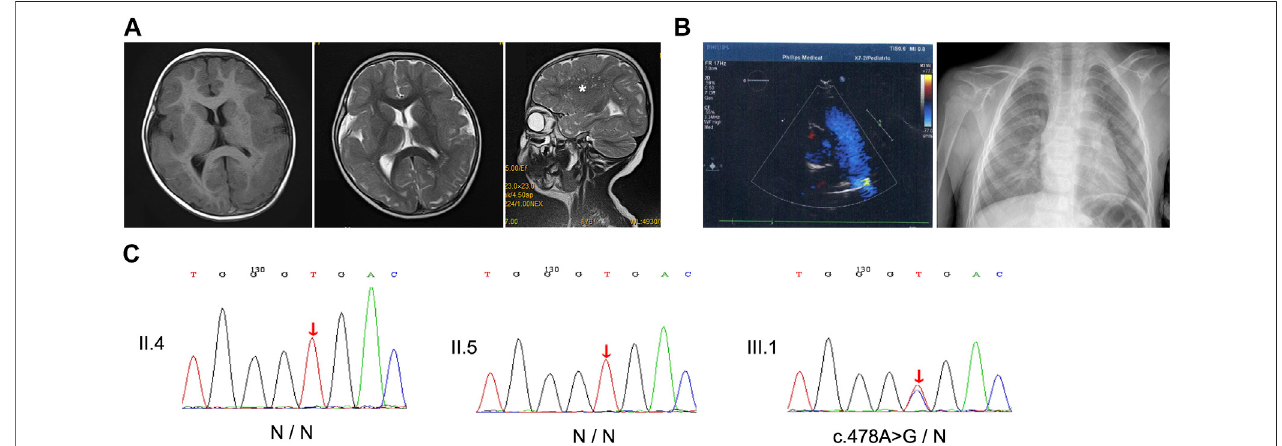
FIGURE 2 | Imaging and Sanger sequencing. (A) Cranial T1- and T2-weighted magnetic resonance imaging (MRI) of the patient at age 3 showed that pachygyria was more pronounced in bilateral frontal lobes, and sagittal T2-weighted image revealed enlarged perivascular spaces (asterisk). (B) Echocardiogram and chest x-ray exclude heart defects. (C) Sanger sequencing presents the heterozygous missense c.478A > G variant in the proband, while his parents did not reveal the presence of the mutation. Red arrows, variant